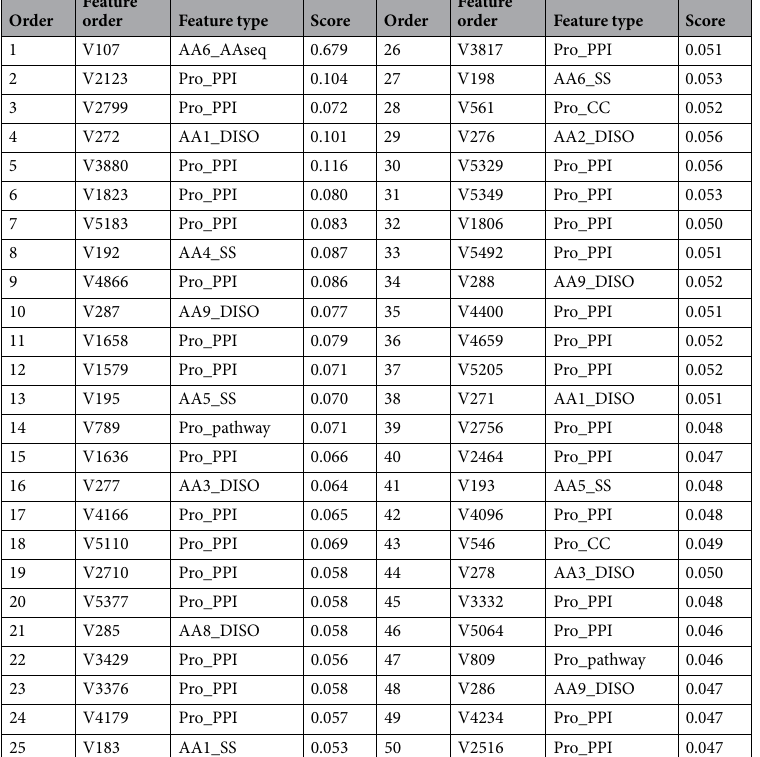
Table 4. The top 50 important features selected by mRMR feature selection for CDKs. Annotations of feature types: AA n _AAseq (V1-V180): Binary encoding amino acid sequence (180-dimensional vector), where n ( n = 1, 2, … 9) denotes the residue position in the local window size of 9 residues. AA n _SS (V181-V207): Secondary structure predicted by SABLE (27-dimensional vector); AA n _SA (V208-V270): Solvent accessibility predicted by SABLE (63-dimensional vector); AA n _DISO (V271-V288): Native disorder predicted by DISOPRED2 (18-dimensional vector); Pro_BP (V289-V536): Over-represented Biological Process features from Gene Ontology (248-dimensional vector); Pro_CC (V537-V587): Over-represented Cellular Component features from Gene Ontology (51-dimensional vector); Pro_InterPro (V588-V774): Over-represented features from InterPro (187-dimensional vector); Pro_pathway (V775-V818): Over-represented pathway features from KEGG (44-dimensional vector); Pro_MF (V819-V895): Over-represented Molecular Function features from Gene Ontology (77-dimensional vector); Pro_domain (V896-V946): Over-represented functional domain features from Pfam (51-dimensional vector); Pro_PPI (V947-V5698): Over-represented protein-protein interactions from PPI (4752-dimensional